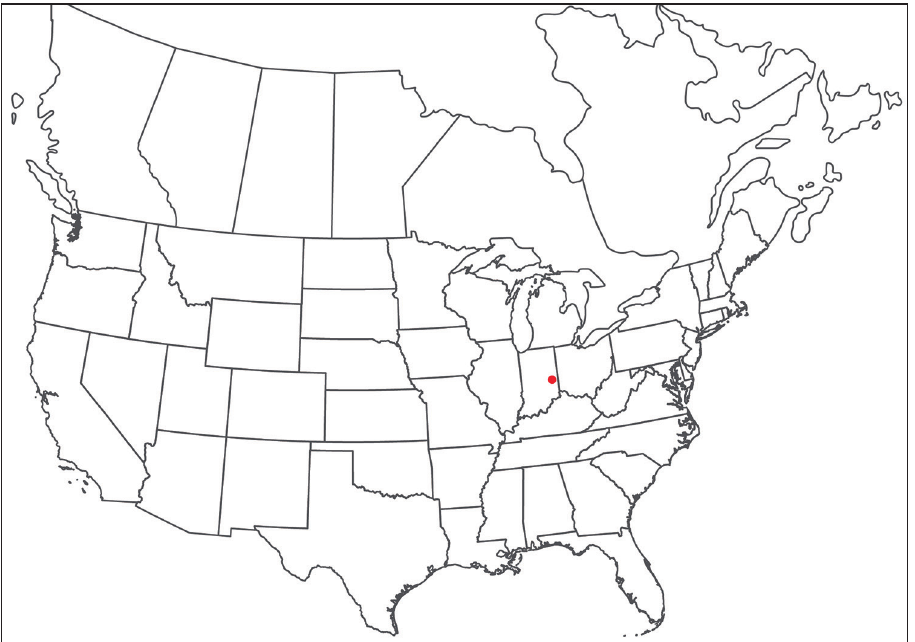
Figure 93. Torrenticola hoosieri sp. n.